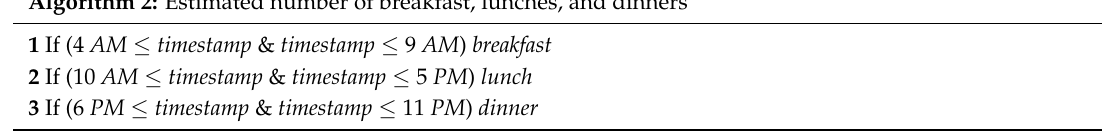
Algorithm 2: Estimated number of breakfast, lunches, and dinners